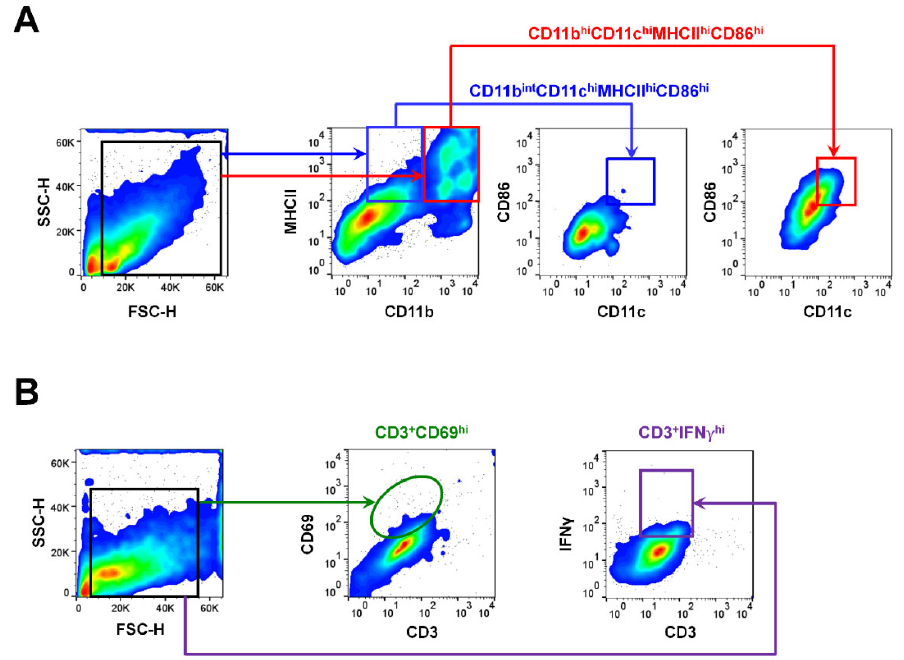
Figure 1. Gating strategies and the distribution pattern of the mature antigen-presenting cell (APC) and T-cell subsets. ( A , B ) Representative photographs of the gating strategies for the identification of APC subsets using the surface marker of CD11b, CD11c, MHCII, and CD86, and T-cell subsets using the surface marker of CD3, CD69, and interferon gamma (IFN γ ) in the ocular surface. To further subclassify APCs into DCs and macrophages in the ocular surface, CD45 + cells were first sorted according to the expression of CD11b or CD11c and were re-gated using the expression of F4/80 and MHCII based on a previous study